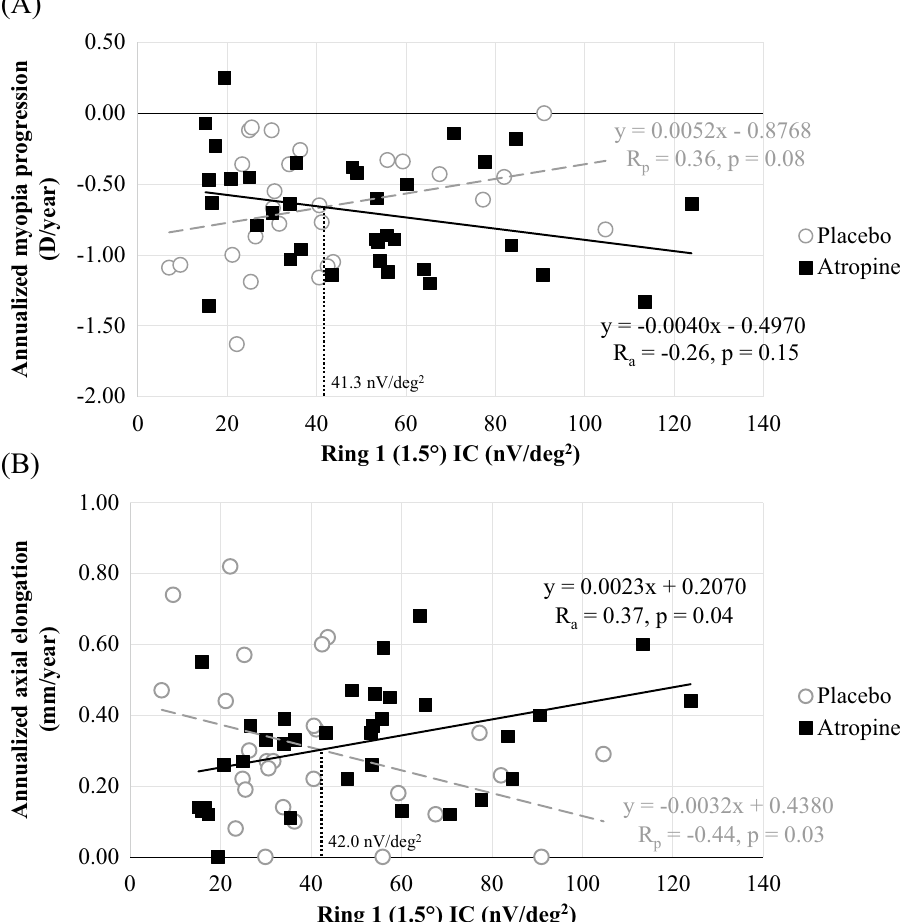
Figure 4. Annualized change in SER and AL by baseline MOFO mfERG response. ( A ) Spherical equivalent refraction; ( B ) Axial length. P-values by Hochberg’s adjustment are presented.